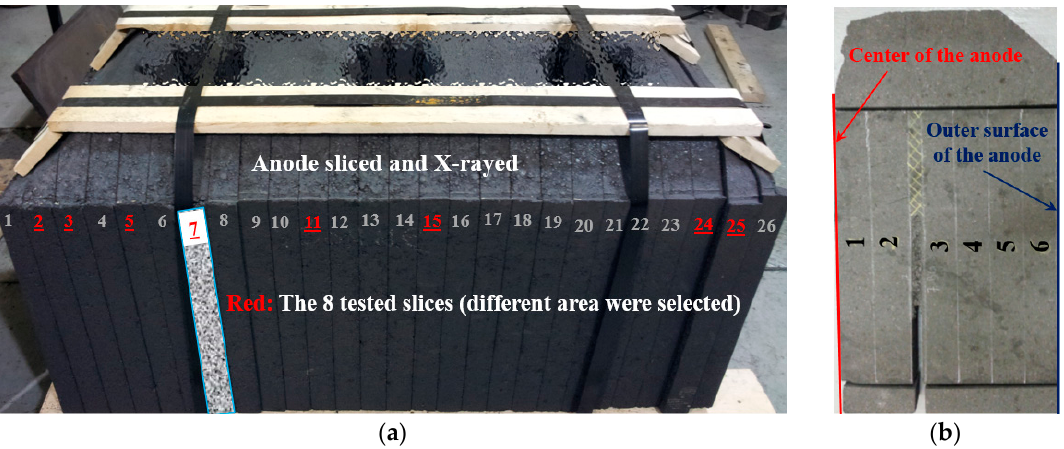
Figure 2. The sliced baked anode. ( a ): The selected eight slices are identified in red; ( b ): Example of the seventh slice used for acoustic testing.